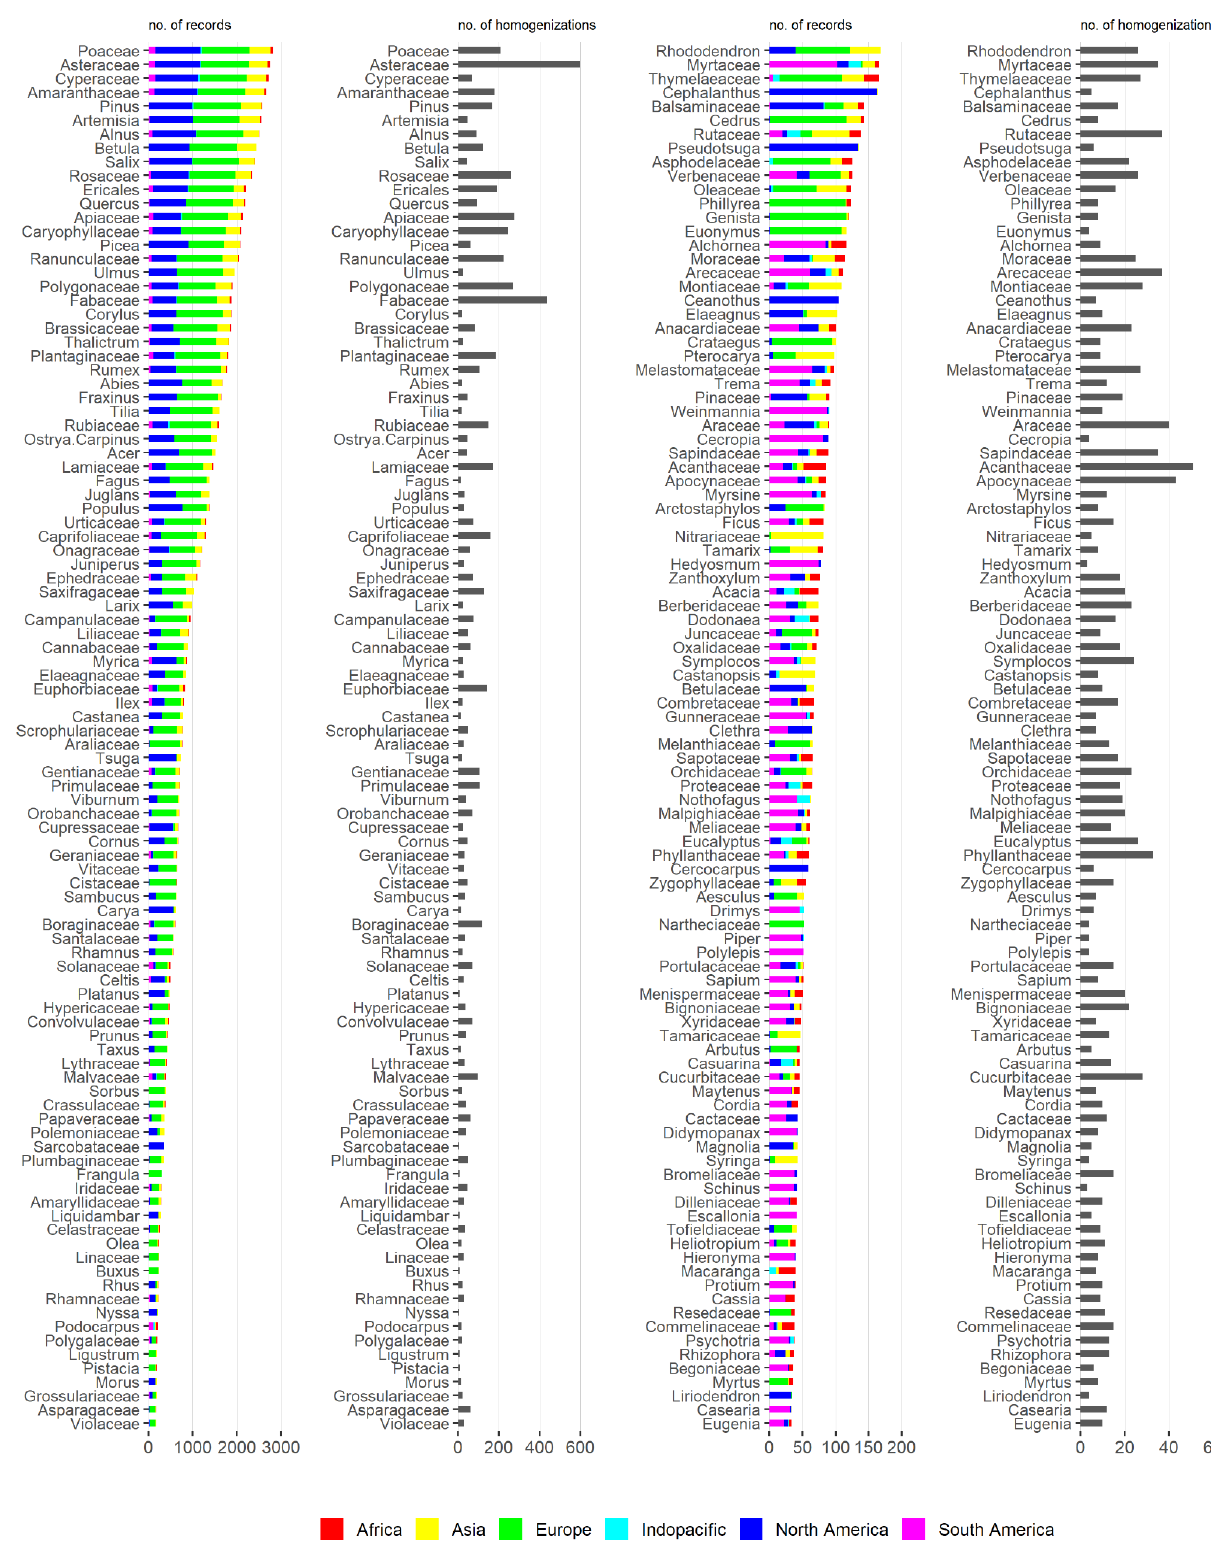
Figure 3. Number of records of each taxon per continent and the number of subsumed variants per harmonized taxon. The figure shows the 200 taxa with the highest number of records in the dataset. A full overview of all taxa is given in Appendix Fig. A1.